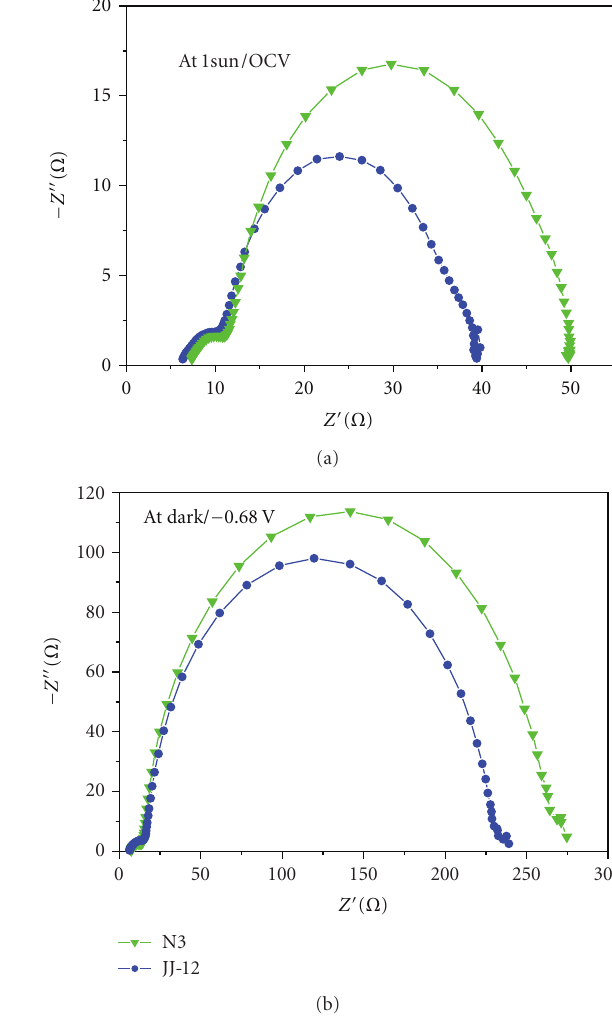
Figure 5: Electrochemical impedance spectra measured under the illumination (1 sun) and in the dark for the cells with di ff erent dye adsorption conditions (i.e., JJ-12 (blue), N3 (green)).